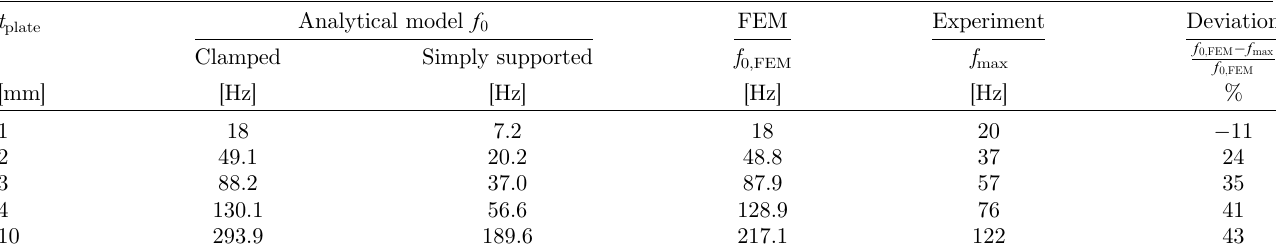
Table 1. Comparison of resonance frequencies of the fl exible-plate resonator with different plate thicknesses using analytical model, fi nite-element model (FEM) and experiments.